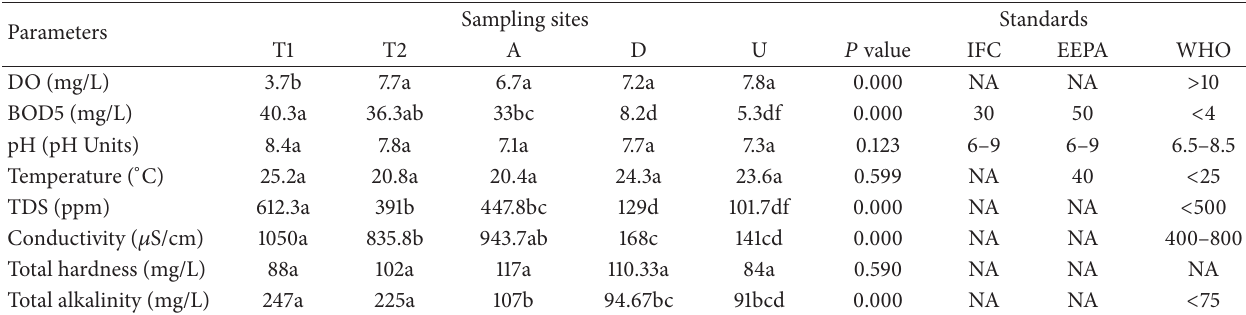
Table 1: Mean values of water quality parameters of study sites compared to guideline values of WHO [12], EEPA [13], and IFC [14]. Different letters within the same row show significant variation among sampling sites according to Tukey HSD ( 𝑃 < 0.000 ).